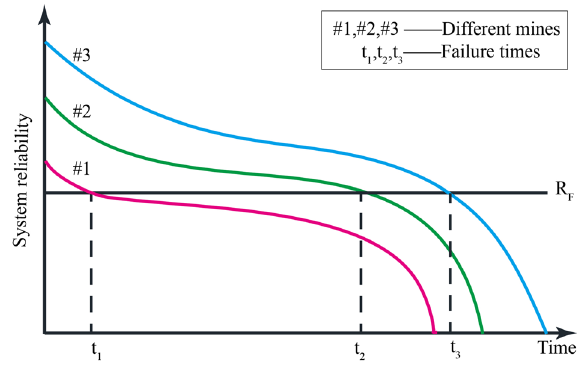
Figure 3. Failure models of different